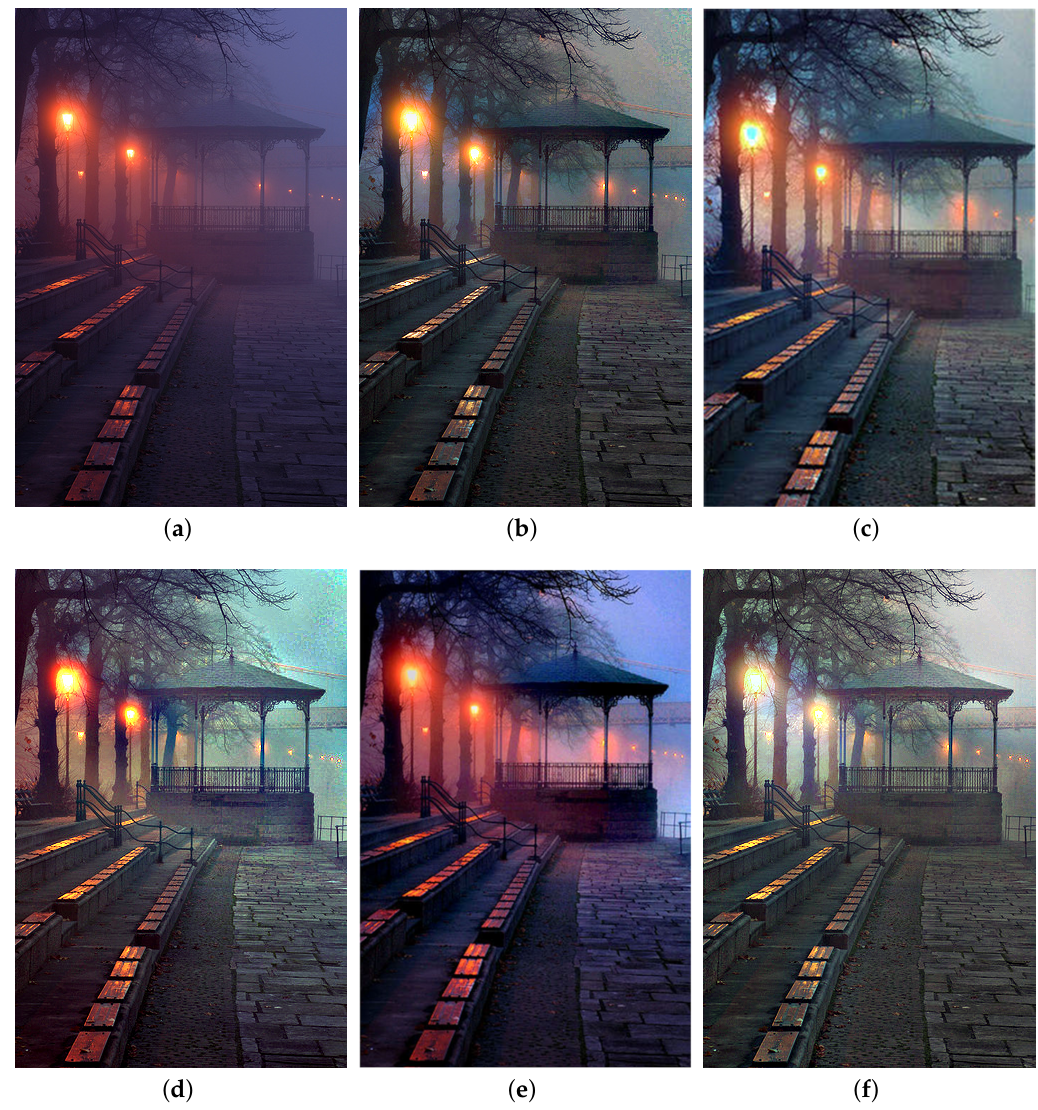
Figure 8. Comparisons with other nighttime dehazing methods on test image Pavilion . ( a ): the nighttime hazy image, ( b ): Zhang’s Maximum Reflectance Prior (MRP) [11] result, ( c ): Lou’s Haze Density Features (HDF) [41] result, ( d ): Li’s Glow and Multiple Light Colors (GMLC) [13] result, ( e ): Yu’s Pixel-wise Alpha Blending (PAB) [9] result, ( f ): SIDE